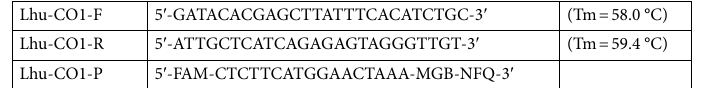
Table 1. Sequences of designed primers and probe. “F” represents a forward primer, “R” represents a reverse primer, and “P” represents a TaqMan probe. The amplificon length was 128